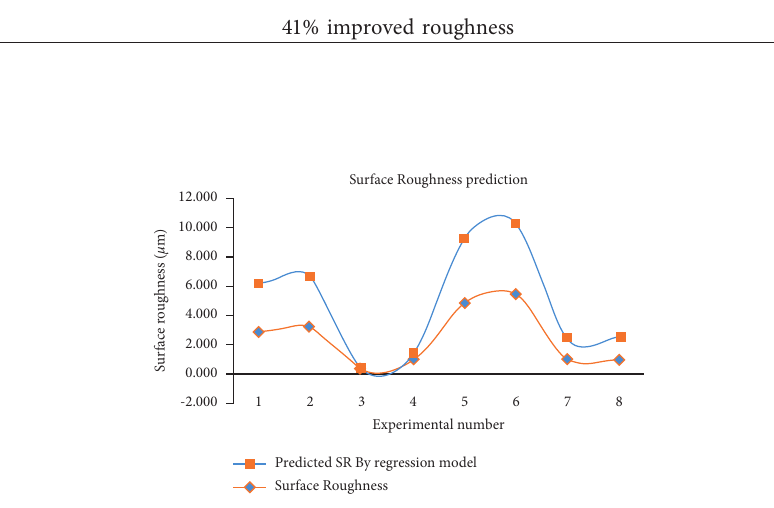
Figure 5: Observed deviations between the experimental SR and predicted SR.